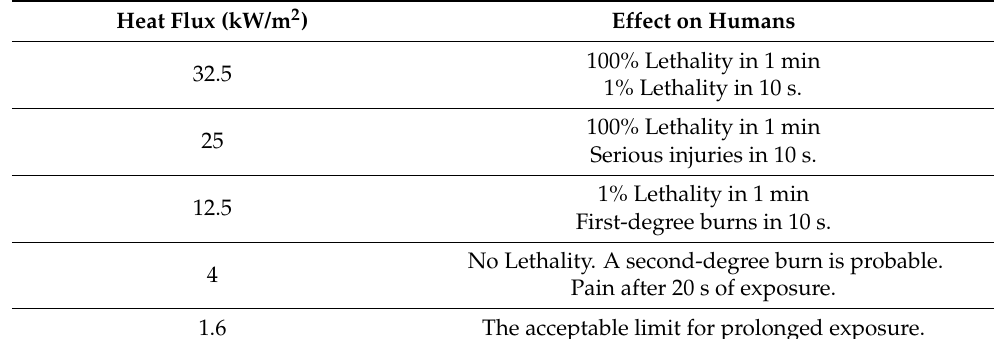
Table 4. Heat flux intensity effects on humans